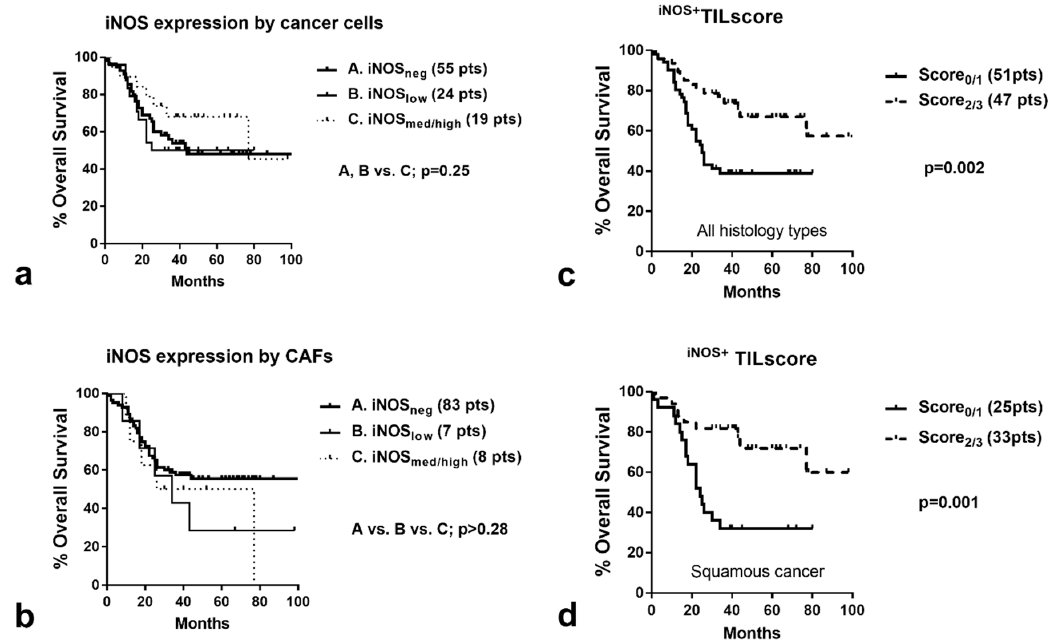
Figure 3. Kaplan–Meier (disease-specific) overall survival curves stratified for ( a ) iNOS expression by cancer cells; ( b ) iNOS expression by Cancer-Associated Fibroblasts; ( c ) iNOS+ TIL score in all histology types; ( d ) iNOS+ TIL score in squamous cell histology.